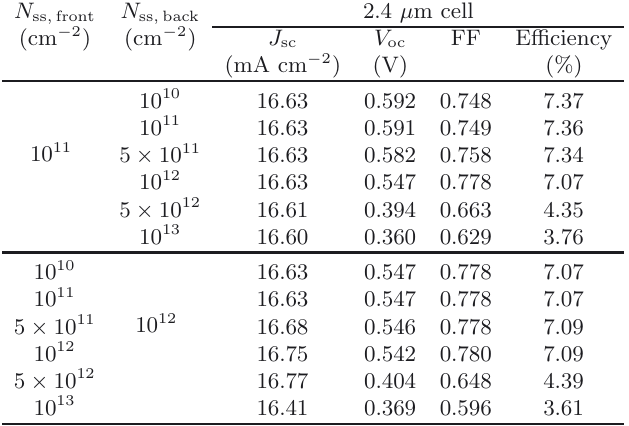
Table 3. Sensitivity to the defect density at the rear epi-Si/P- c-Si interface ( N ss , back ) and to that at the front N-a-Si:H/epi-Si interface ( N ss , front ).